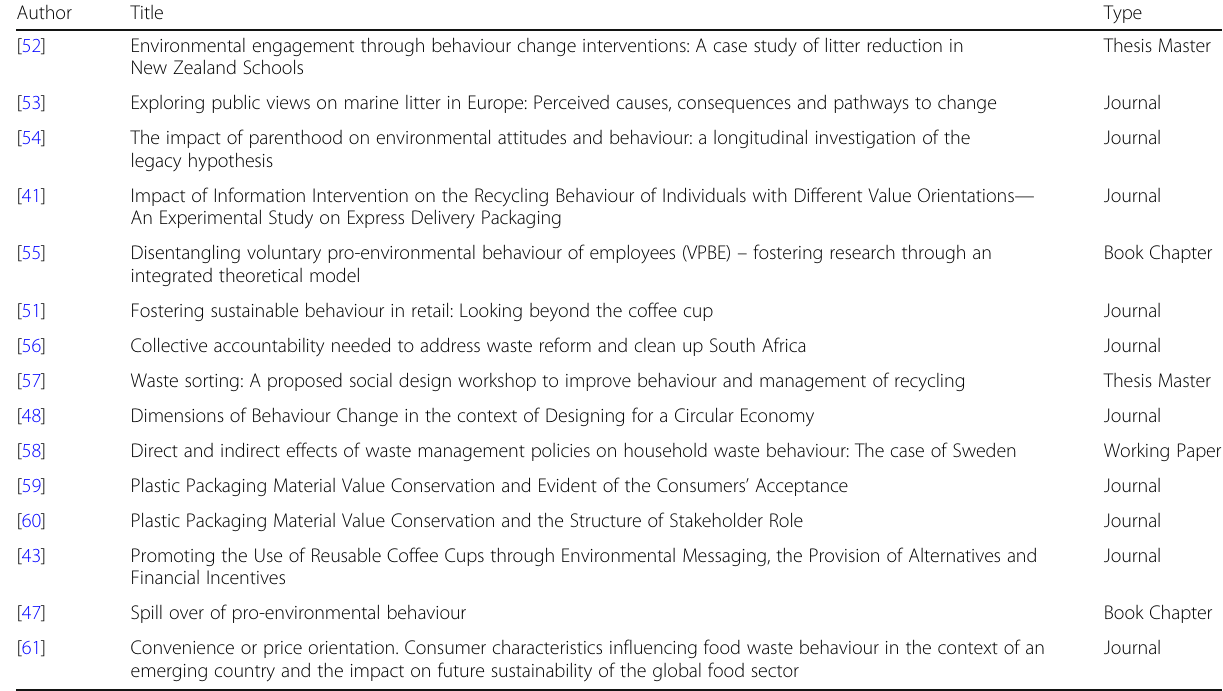
Table 1 Fifteen of the first fifty entries found on “ Google Scholar ” on the 12 of February 2019 using the search terms “ Behaviour Change ” and “ Packaging ” . These articles all cover behaviour change around sustainable